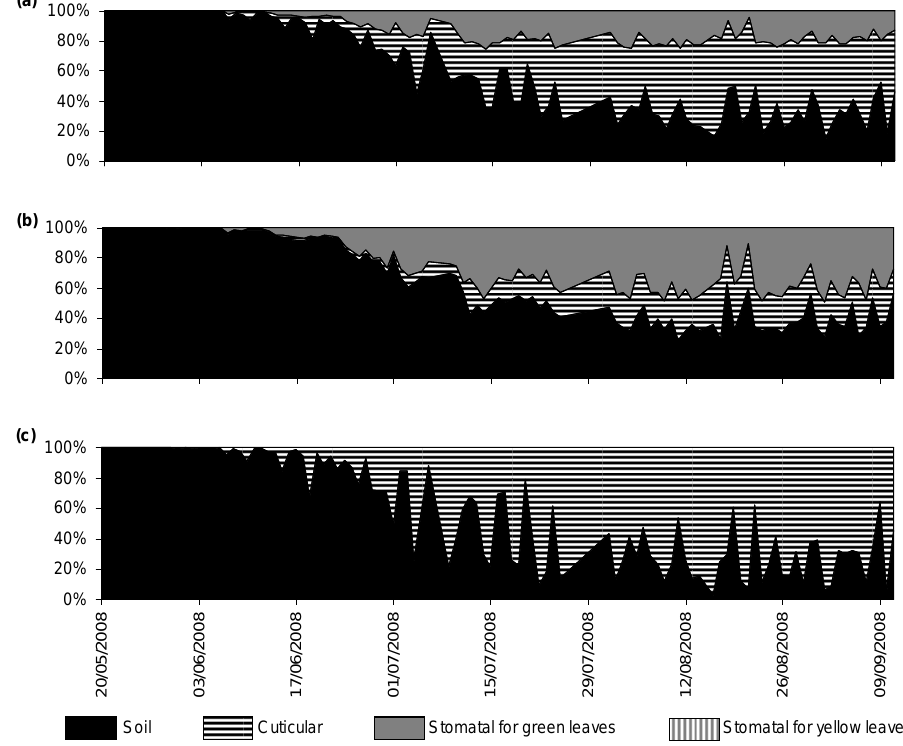
Fig. 9. As in Fig. 8, but for the Lamasqu`ere Figure 9: As in Figure 8, but for the Lamasquère site. 21